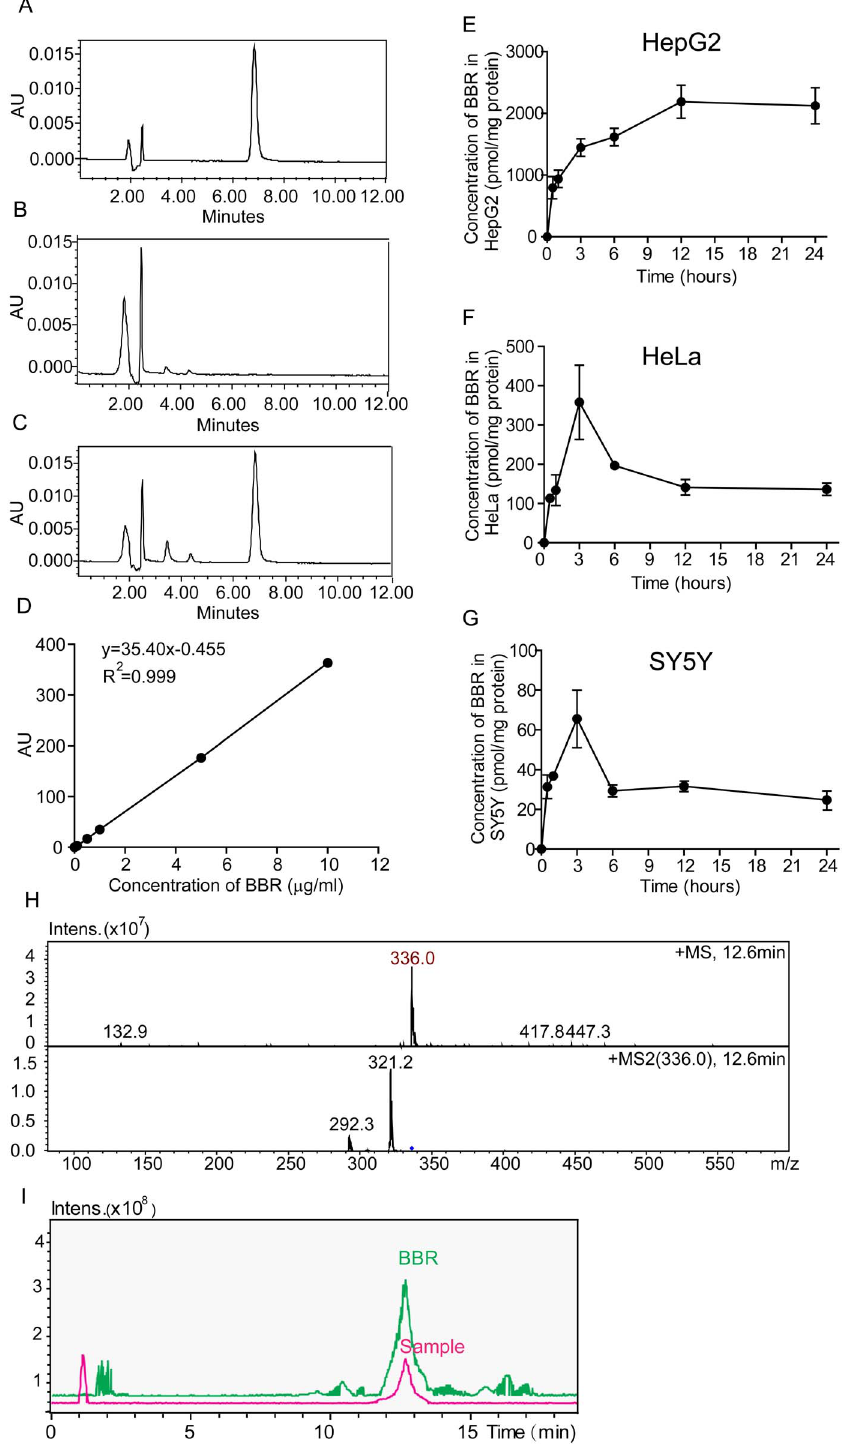
Figure 3. Chromatograms and kinetic behavior of BBR in the three cell lines. (A–C) HPLC chromatograms. (A) Standard BBR; (B) Blank sample from BBR treated cells; (C) Samples from cells with BBR administration for 12 h. (D) Standard curves of BBR concentration verse AU intensity using HPLC assay. (E–G) Kinetic behavior of BBR in the cells in plot with the administration time in 24 h. (E) HepG2; (F) HeLa; (G) SY5Y cells. (H, I) LC/MS chromatograms of BBR in HepG2 cells after the administration for 24 h. (H) the mass spectrum of BBR; (I) the chromatogram of BBR. Standard BBR was shown in green; the sample was shown in purple color. Data are presented as mean 6 S.D. from six independent experiments (n=6).